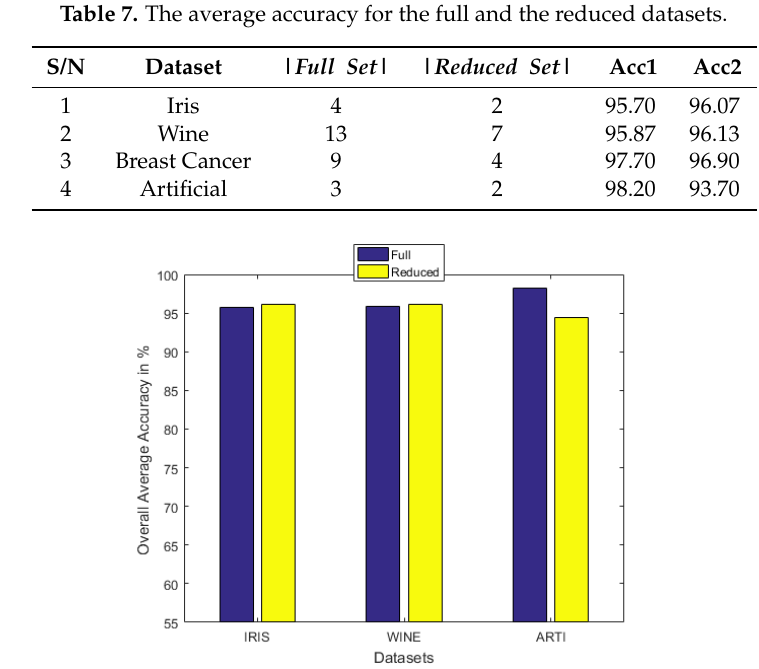
Figure 8. The average accuracy for the full and the reduced datasets.